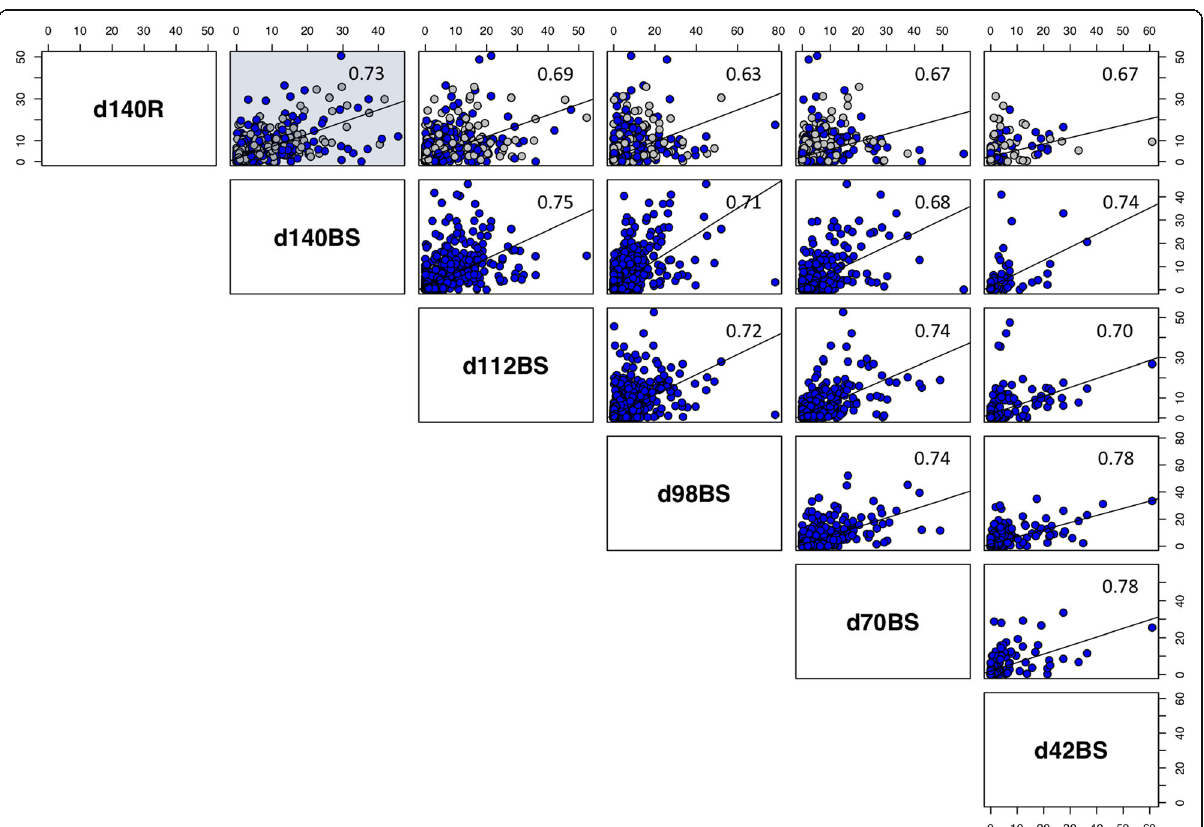
Fig. 2 Scatter plots for analysis of differences in the relative abundances of each RS bacterial taxon, among sample types. The circles (o) are representing RS bacterial taxon in R and BS samples. The same animals were compared among sample types: a total of 36 animals (day 140R vs. day 140BS), 36 animals (day 140R vs. day 112BS), 35 animals (day 140R vs. day 98BS), 19 animals (day 140R vs. day 70BS) and 6 animals (day 140R vs. day 42BS). Spearman correlation coefficients (R-values) are indicated. Correlation in terms of microbial taxa abundance between d140R vs. d140BS is illustrated in the upper left corner highlighted with a light blue background. Grey dots represent RS samples and blue dots represent BS